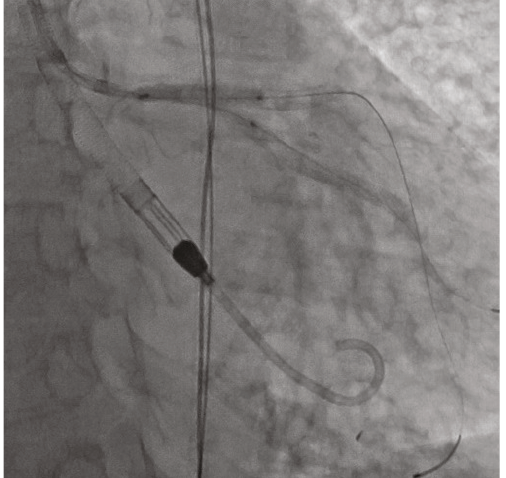
Figure 1: Left coronary angiogram showing a moderate stenosis (arrow) of the left anterior descending coronary artery.